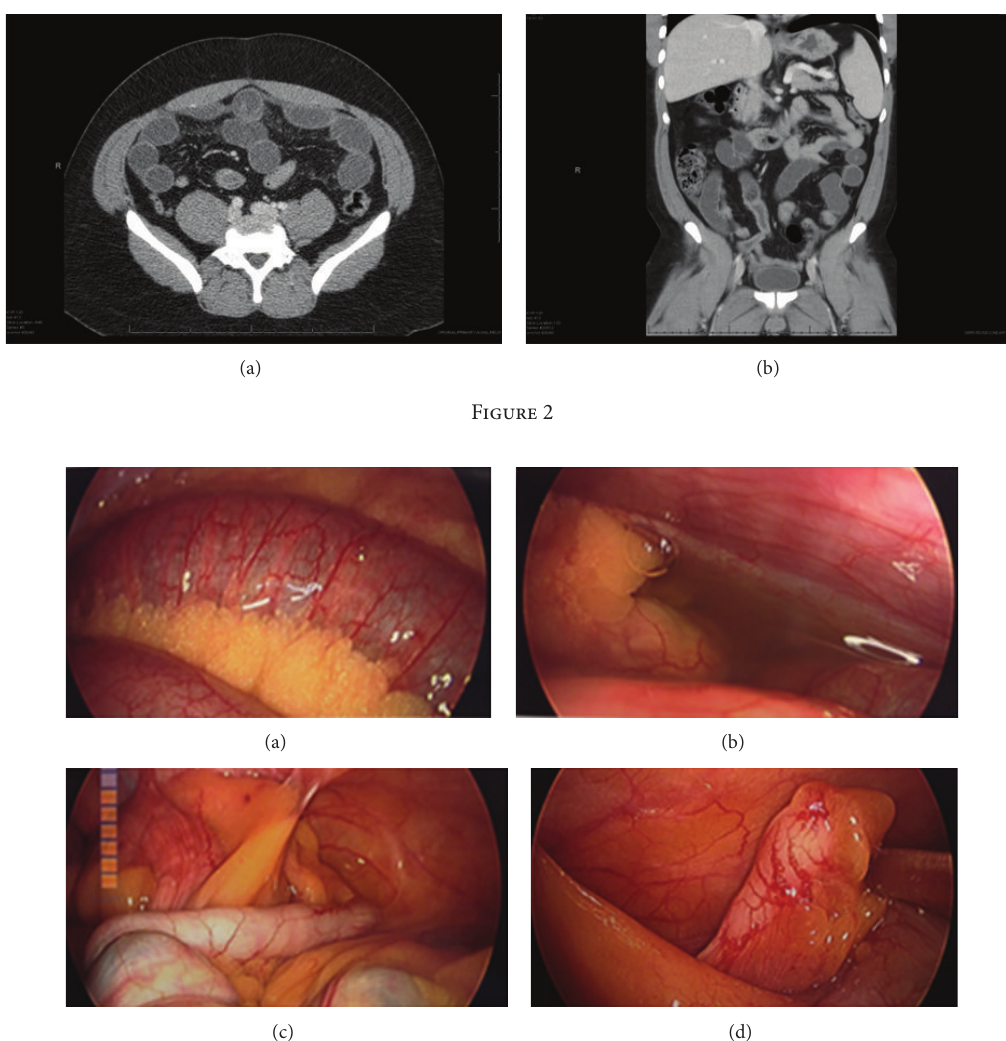
Figure 3: (a) Mildly dilatated small bowel, (b) turbid fluid paracolic gutter, (c) normal appendix, and (d) serositis at tip of